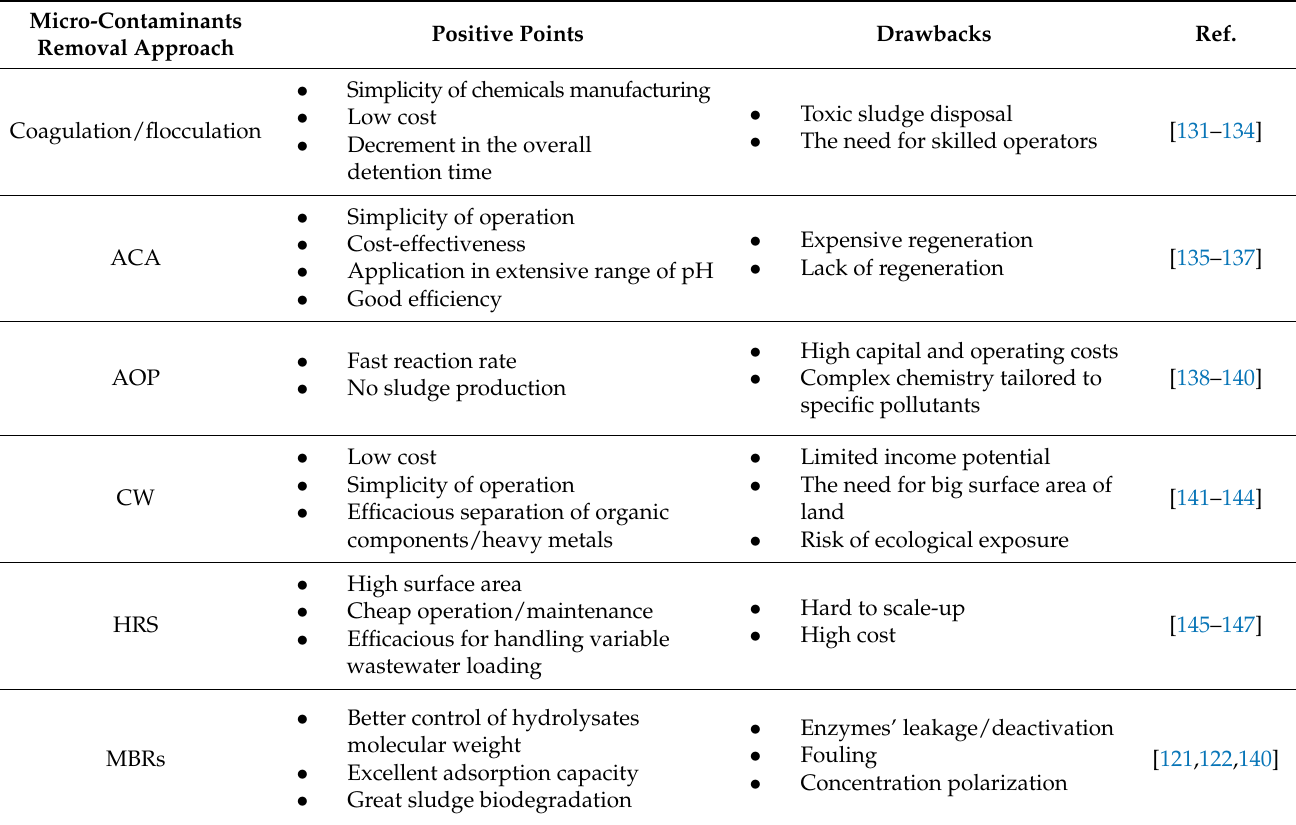
Table 5. Advantages/disadvantages of commonly applied techniques for micro-contaminant removal. Positive Points Drawbacks